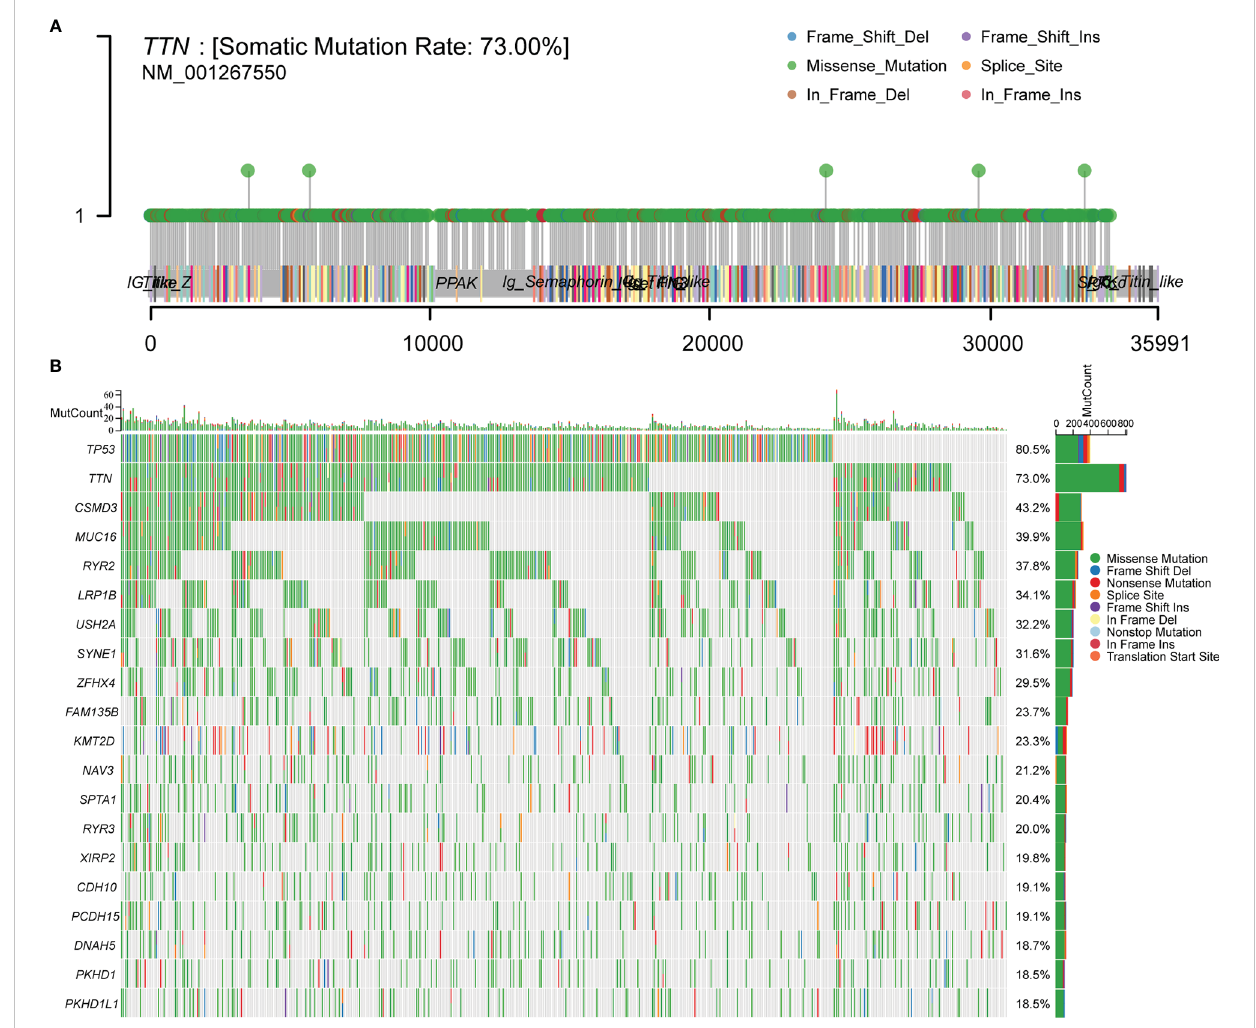
FIGURE 1 Downloading and visualizing somatic mutations in patients with LUSC using the maftools package in R software for TCGA data. (A) Lollipop plot of TTN gene mutation distribution with 73% mutation rate in somatic cells. (B) Somatic cell landscape of LUSC patient cohort with genes sorted by mutation frequency and samples sorted by disease histology; sidebar plot showing log 10 transformed Q -values estimated by MutSigCV. The waterfall plot shows mutation information for each gene in each